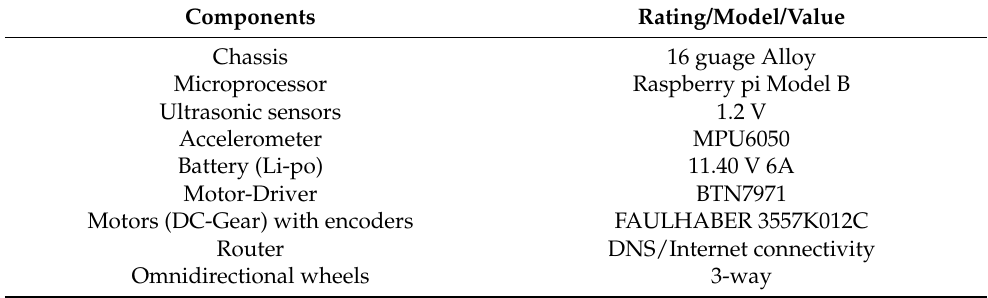
Table 3. Components of